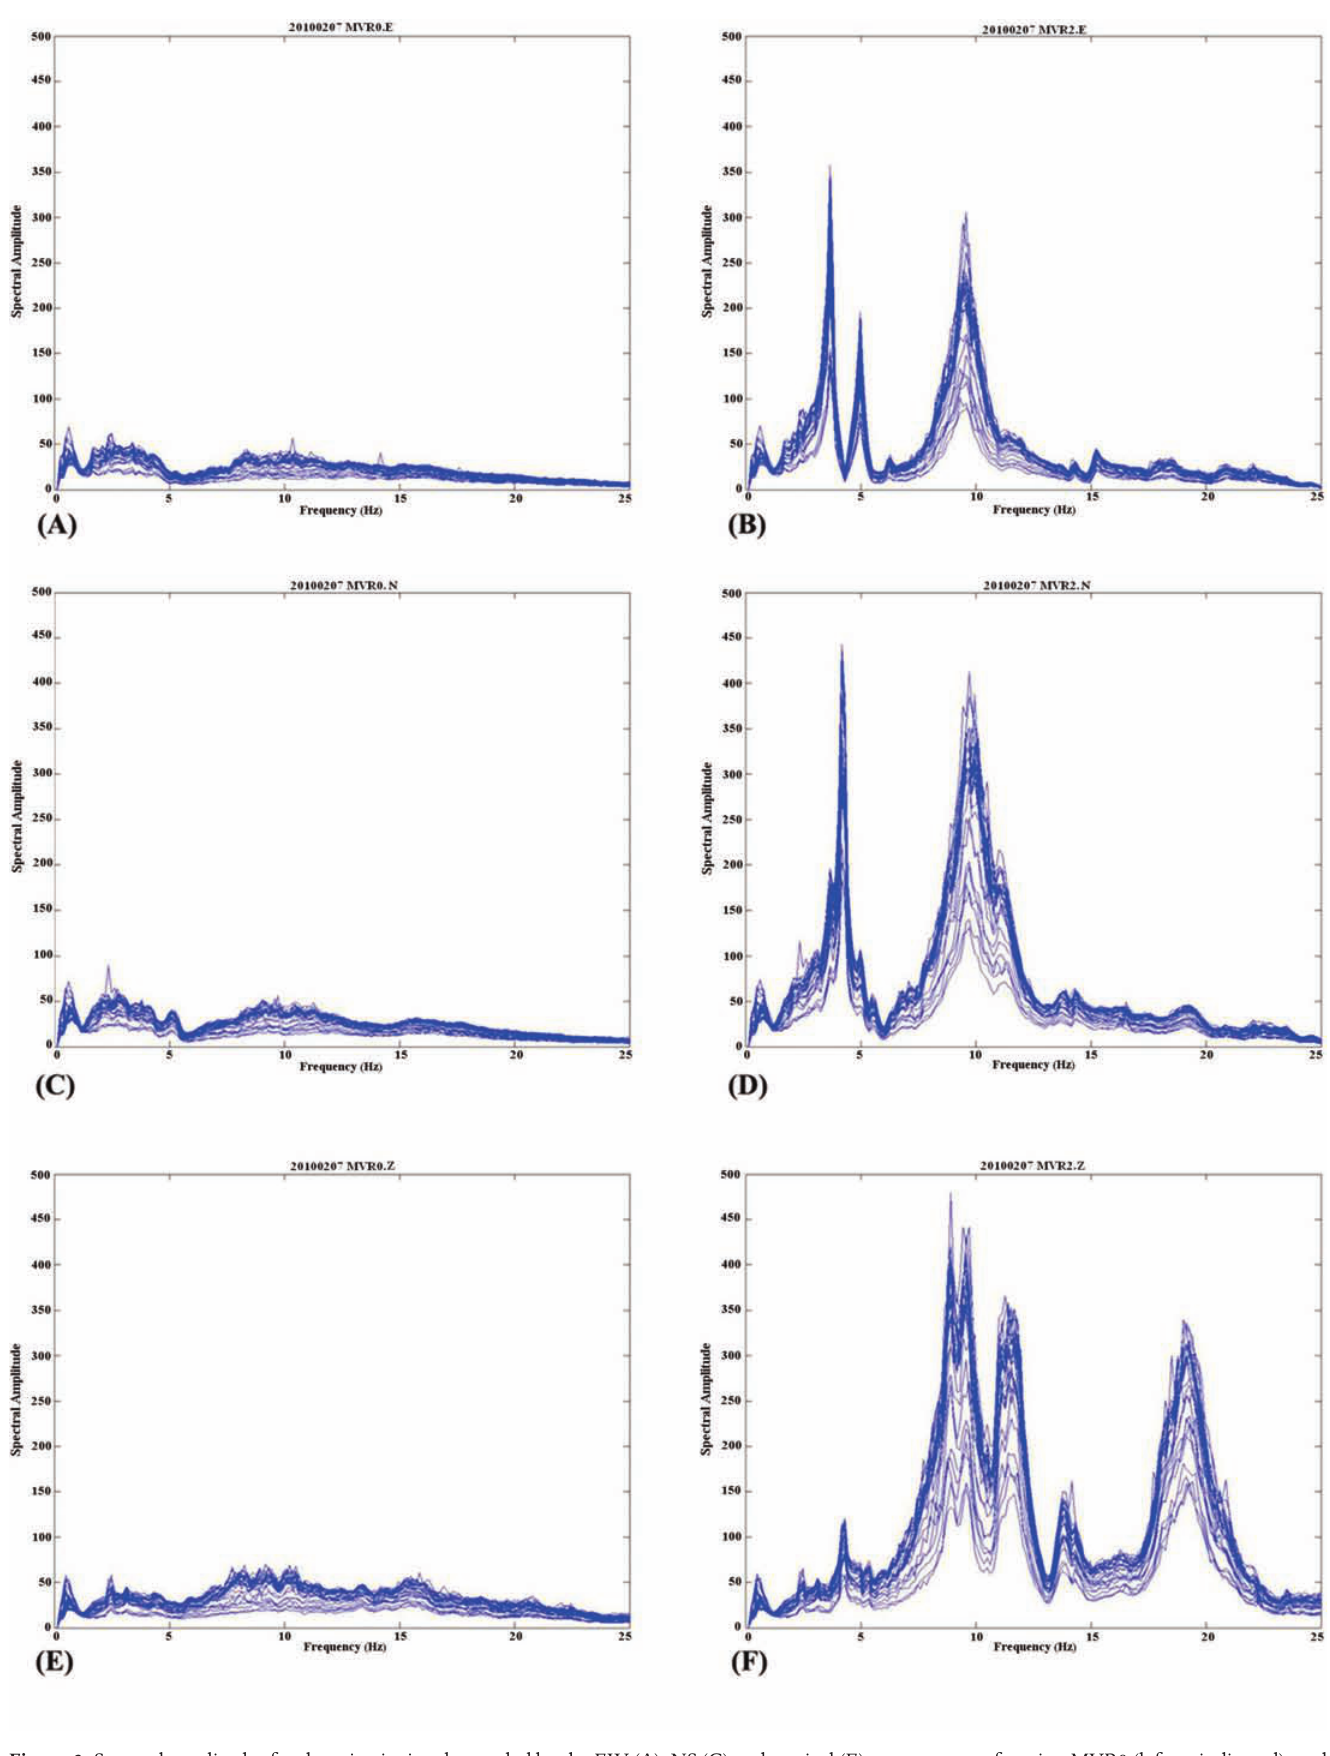
Figure 3. Spectral amplitudes for the seismic signal recorded by the EW (A), NS (C) and vertical (E) components of station MVR0 (left, as indicated), and for the EW (B), NS (D) and vertical (F) components of station MVR2 (right, as indicated). The signals were recorded on February 7, 2010. Each line corresponds to a 1-h-long time